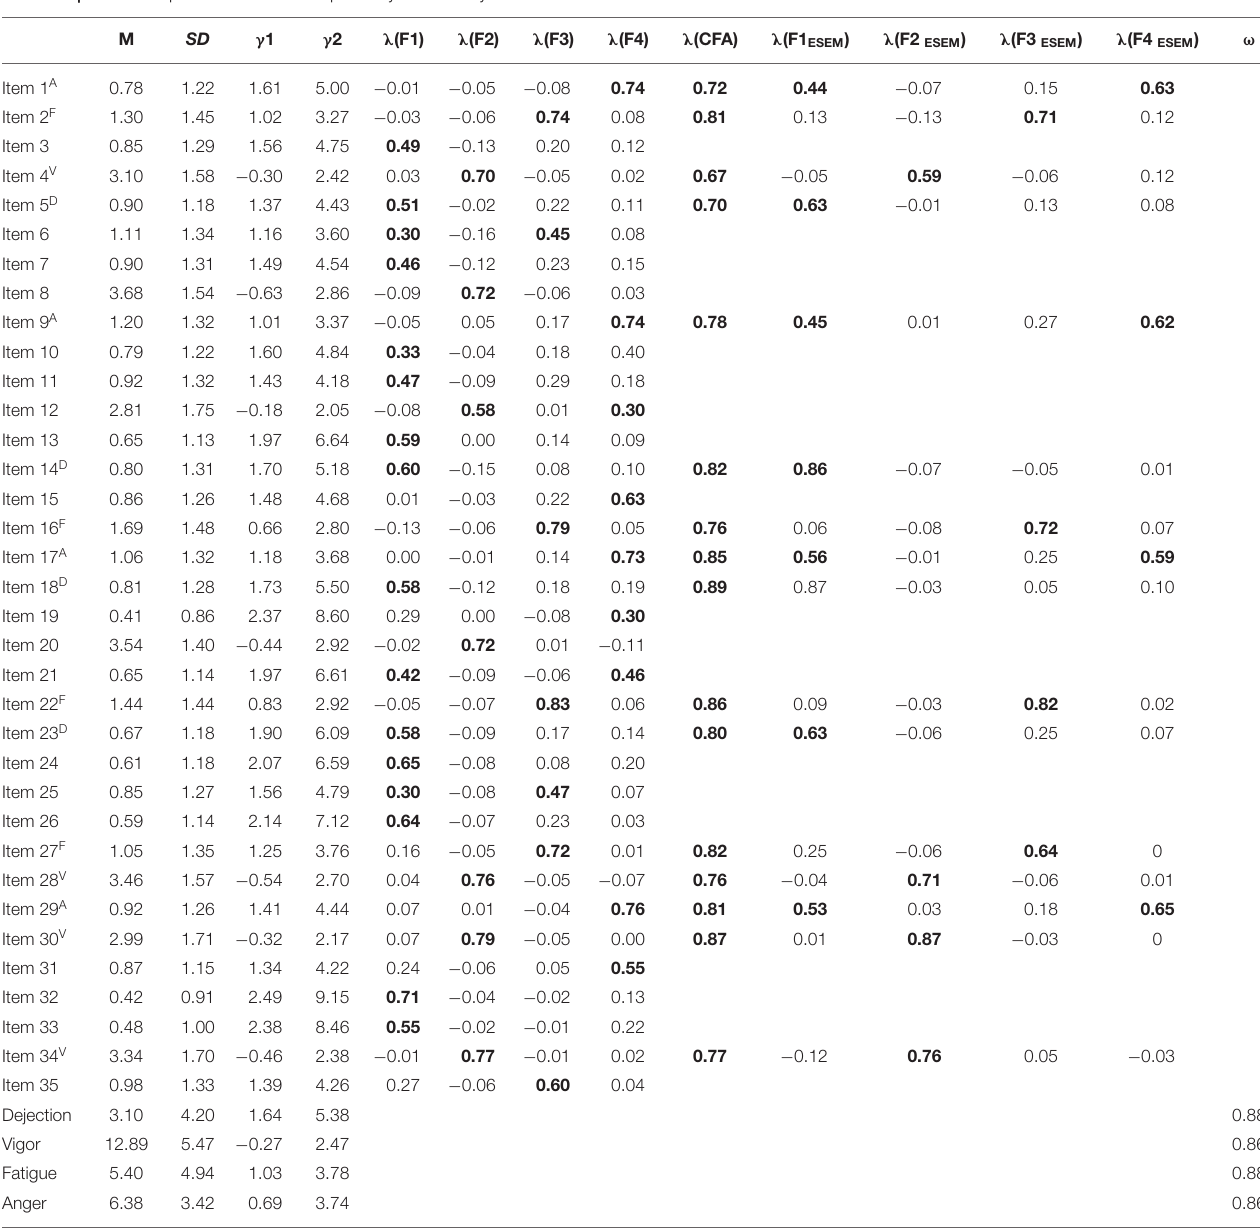
TABLE 2 | Item descriptive statistics and exploratory factor analysis of the